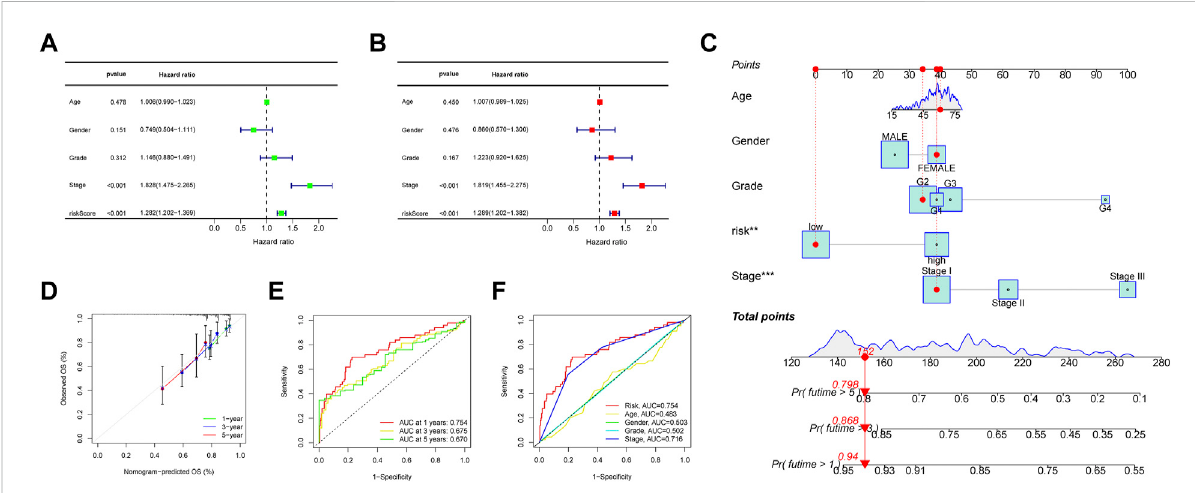
FIGURE 6 (A, B) Forest plots of the uni- and multi-Cox regression analyses in HCC, (C) the nomogram-combined risk score, age, and tumor stage to predict the 1-, 3-, and 5-year OS in HCC and (D) evaluation of the nomogram by correlating it with the calibration curves. (E) The ROC curves of the model for prognosis, and (F) the ROC curves of the risk score and clinicopathologic features.